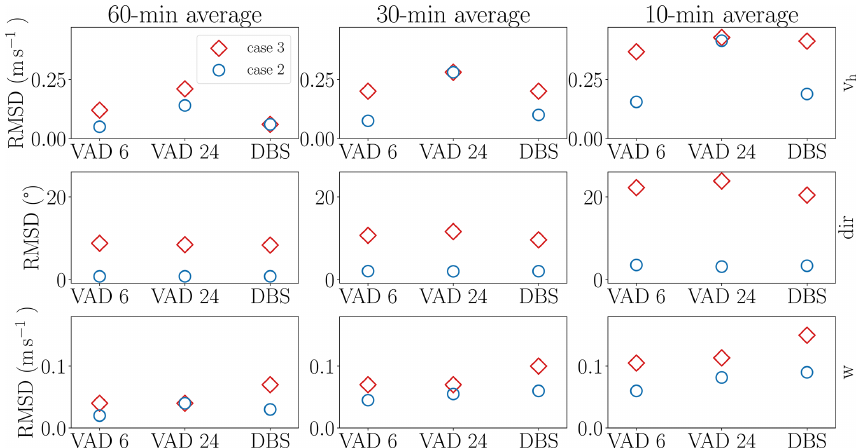
Figure 7. Simulation cases 2 and 3: RMSD of virtual lidar measurements of wind speed, wind direction and vertical wind with reference to the “true” wind profile of the column located directly above the lidar. RMSD values were calculated over a height interval extending from 50 to 860m (from 50 to 960m) for case 2 (case 3). Measurements are averaged over different time intervals. Shown are results for measurements with a zenith angle configuration of 15 ◦ . Measurements were obtained with different scan schemes (VAD 6, VAD 24 and DBS). Blue circles denote results for simulation case 2, while red diamonds indicate results for simulation case